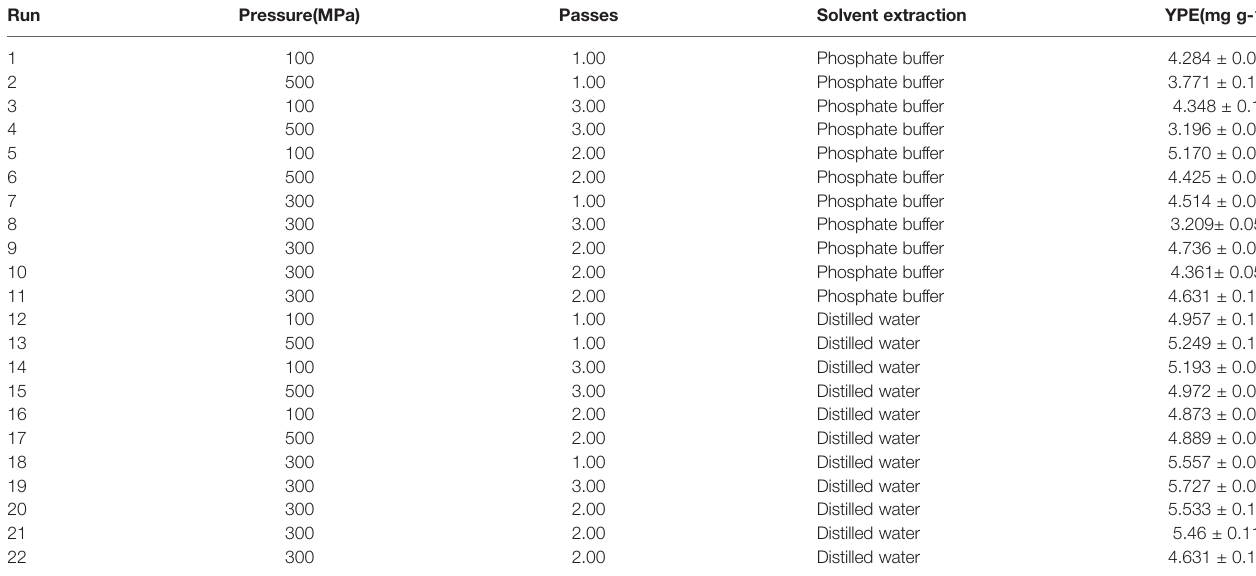
TABLE 2 | Central composite design for high pressure homogenization-assisted method and yield (YPE) from response surface method analysis. Run